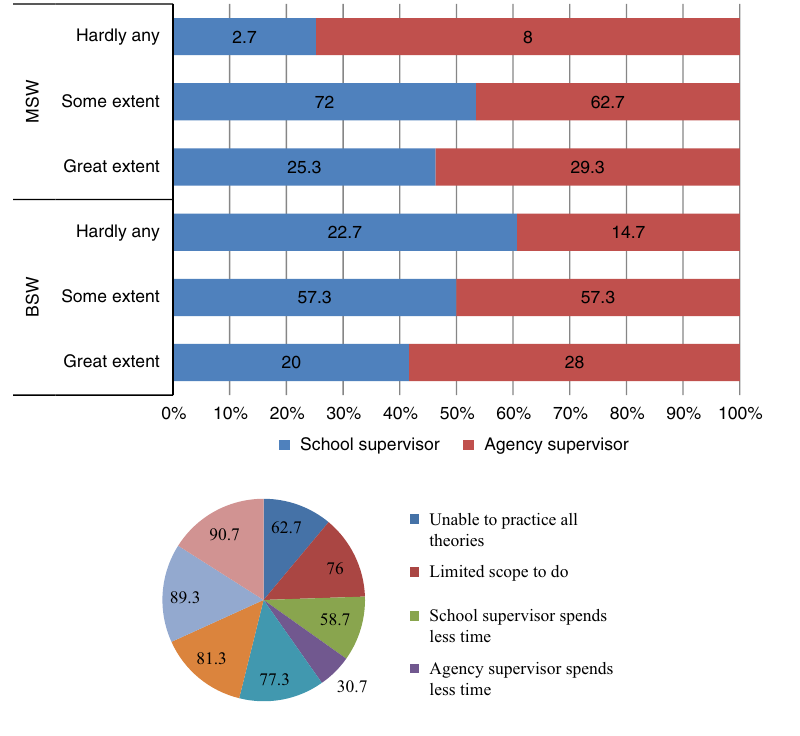
Figure 18. Challenges